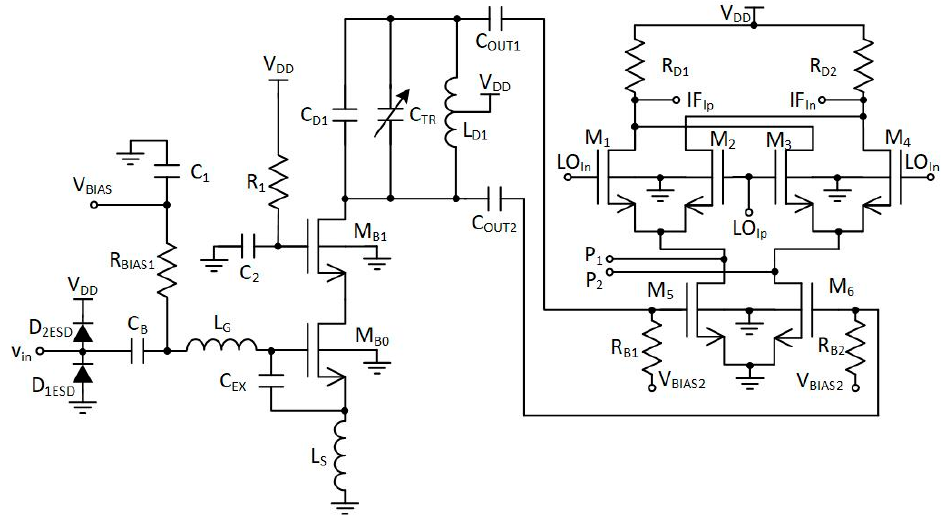
Figure 8. Active balun with ESD (electrostatic discharge) protection and a simplified in-phase mixer.